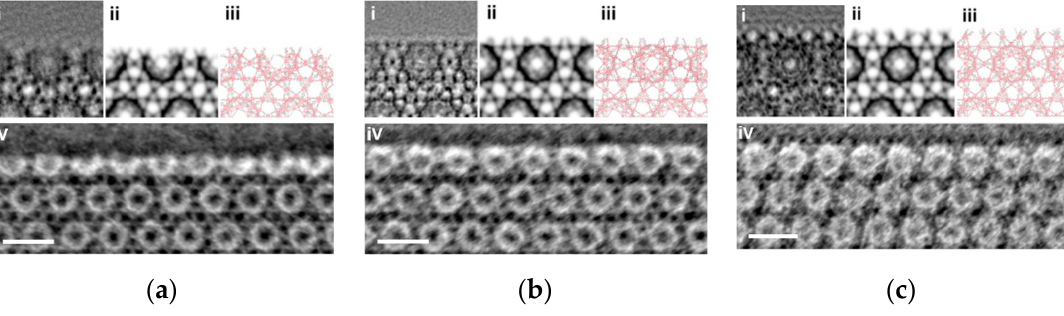
Figure 17. A series of electron microscopy images of the different surfaces in MIL-101: ( a ) The boundary includes most of the cage structure; ( b ) The boundary includes the whole of the cage structure; ( c ) The boundary includes few of the cage structure. And ( i ) HRETM; ( ii ) simulated image; ( iii ) structure model; ( iv ) iDPC-STEM. Reprinted/adapted with permission from Ref. [114]. Copyright 2019, American Chemical Society.